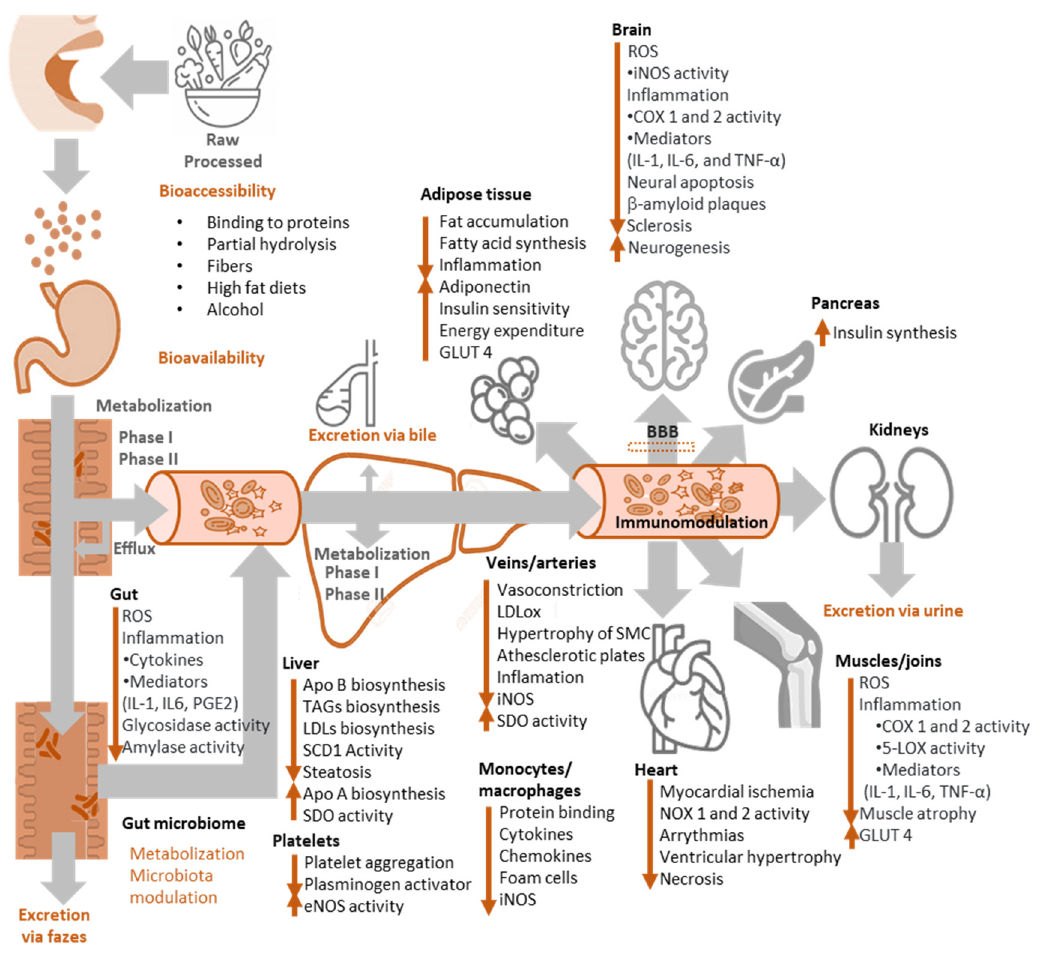
Figure 12. Fate of antioxidants in the body and main bioactivities attributed to